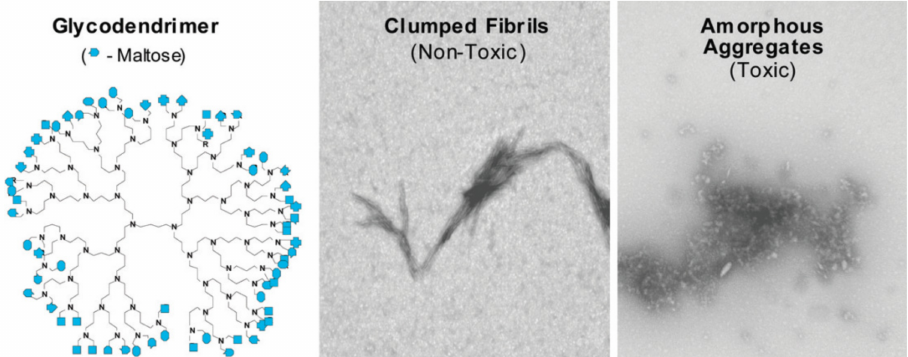
Figure 9. Structure of maltose (Mal)-modified PPI dendrimers and morphology of dendrimer–A β (1– 40) amyloid aggregates. Transmission electron microscopy micrographs of A β (1–40) incubated at pH 7.4 in the presence of PPI-G4-Mal at a dendrimer–peptide ratio of 0.1 (detection of clumped fibrils) and in the presence of PPI-G5-Mal at a dendrimer–peptide ratio of 1 (detection of amorphous